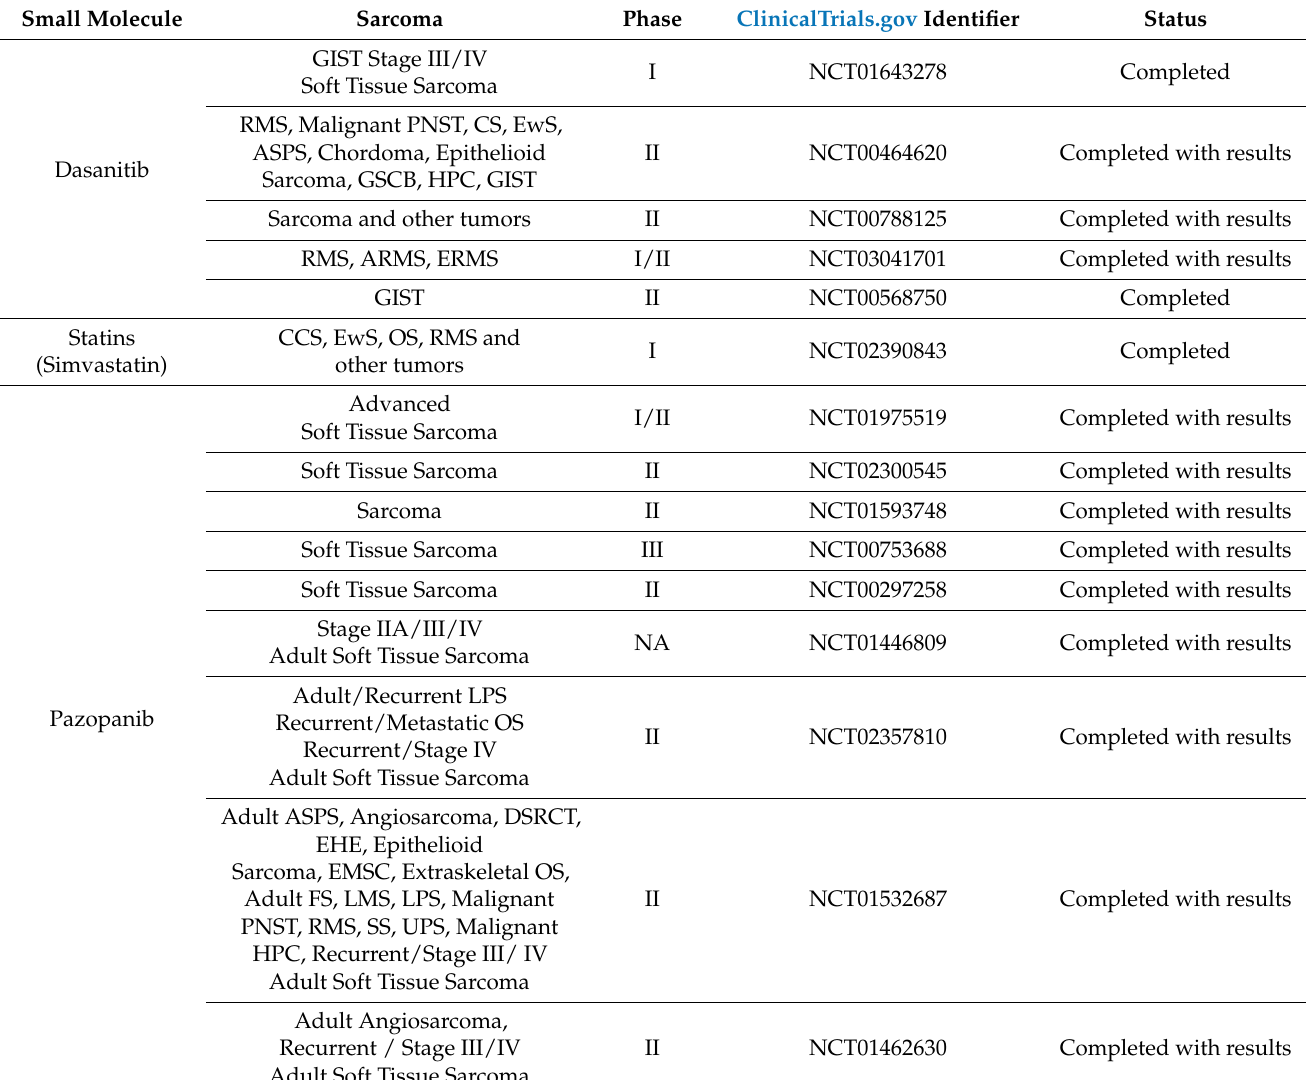
Table 2. List of Hippo pathway-regulators under clinical investigation for treating sarcomas. Source: ClinicalTrials.gov (accessed on 14 November